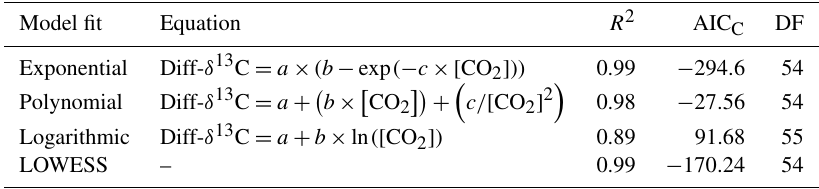
Table 1. Correction factor models are fitted for Diff- δ 13 C, DF (degrees of freedom), AIC C (Akaike information criterion), and [CO 2 ] CO 2 concentration in ppm.